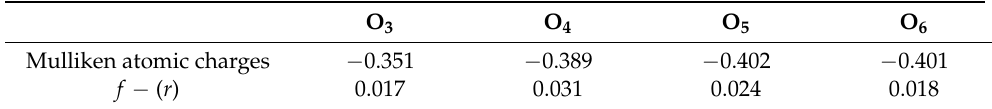
Table 1. Mulliken atomic charges and Fukui function of oxygen